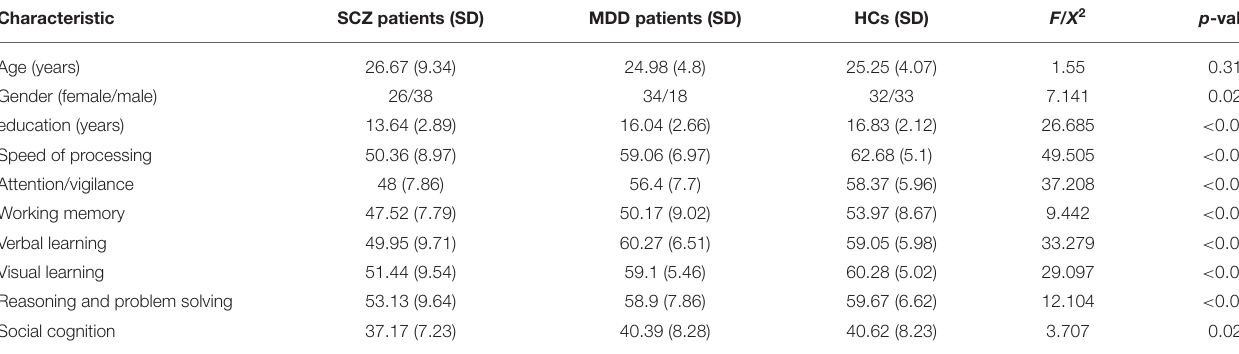
TABLE 1 | Demographic and behavioral characteristics of schizophrenia patients, major depressive disorder patients, and healthy controls.